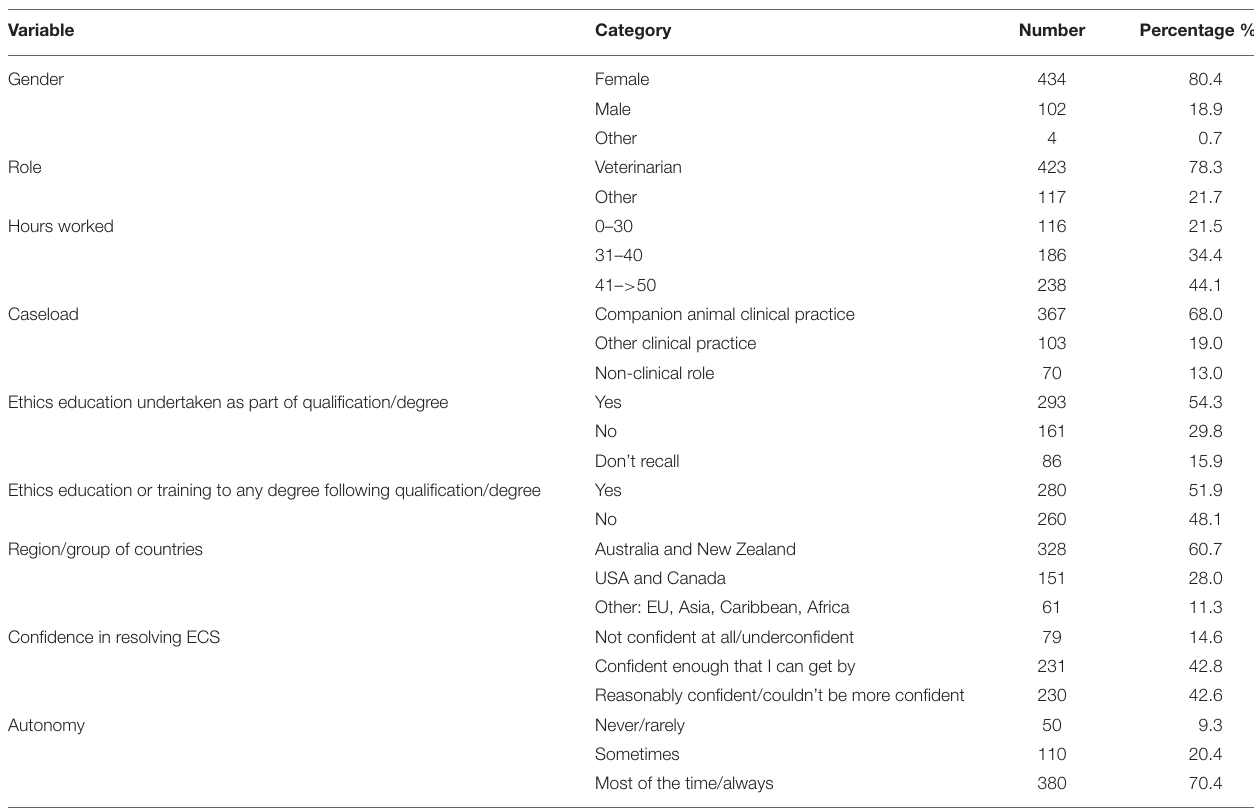
TABLE 1 | Frequency table for the re-categorized demographic information on respondents to a mixed methods survey on ethically challenging situations encountered by veterinary team members globally in the early stages of the COVID-19 pandemic ( n = 540).